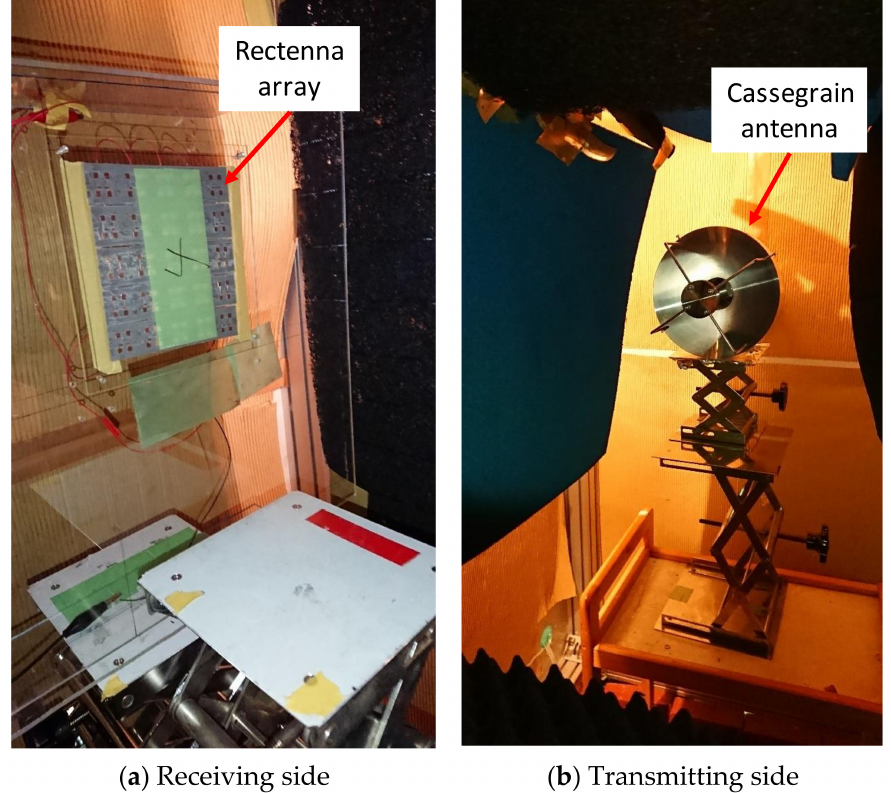
Figure 11. Experimental system of wireless power transmission using 28 GHz gyrotron: ( a ) receiving side and ( b ) transmitting side.